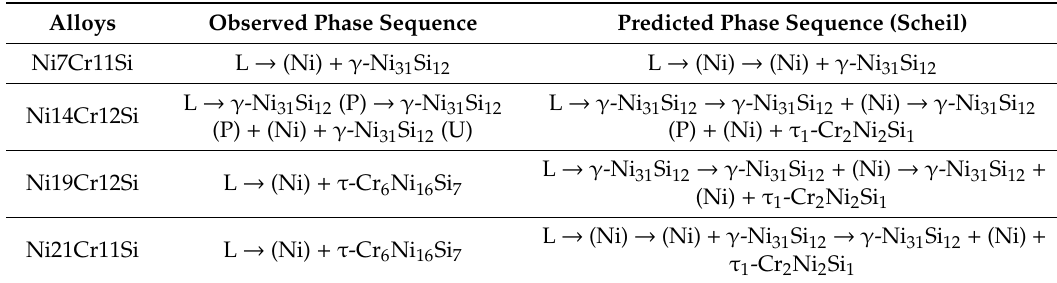
Table 3. Observed phase transformation sequences in the smallest spheres (r = 0.5 mm, 11,000 K s -1 ) during rapid solidification and